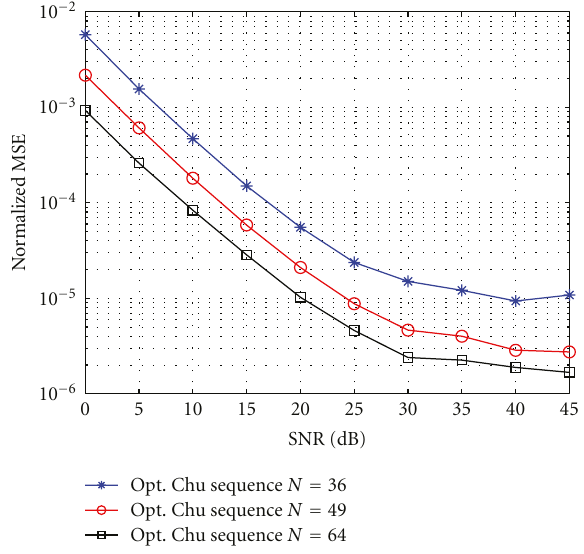
Figure 6: Comparison of CFO estimation using di ff erent length of optimal Chu sequences for L = 18 channel for uniform power delay